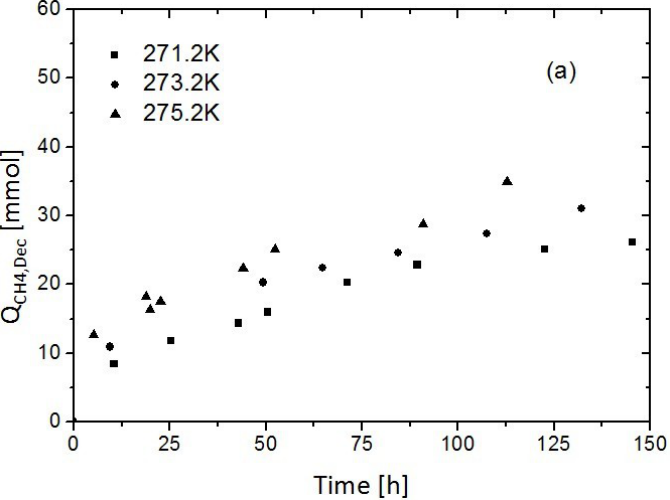
Figure 4. Amount of the decomposed CH hydrate ( Q ); ( b ) against CO 2 ,Form